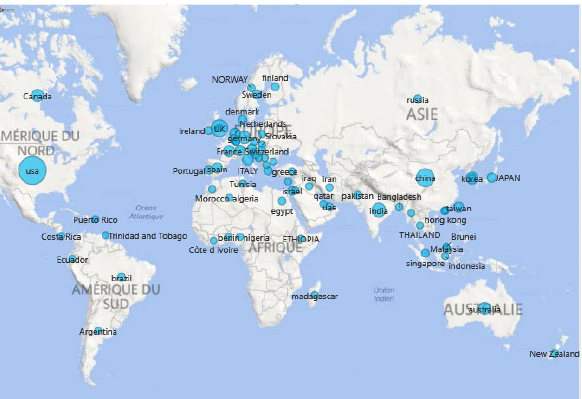
Figure 5. Mapping of countries number of publications in Big